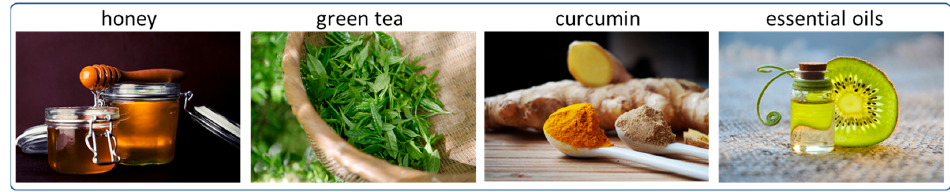
Figure 5. The most popular biological extracts used in antimicrobial hydrogels.